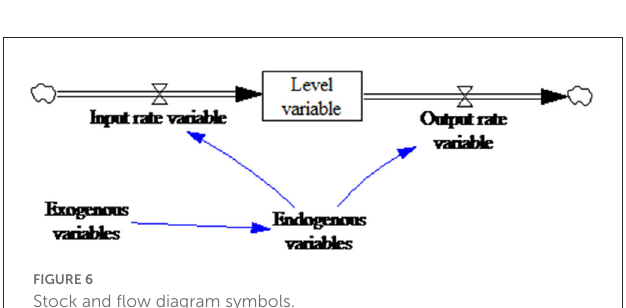
FIGURE6 Stock and flow diagram